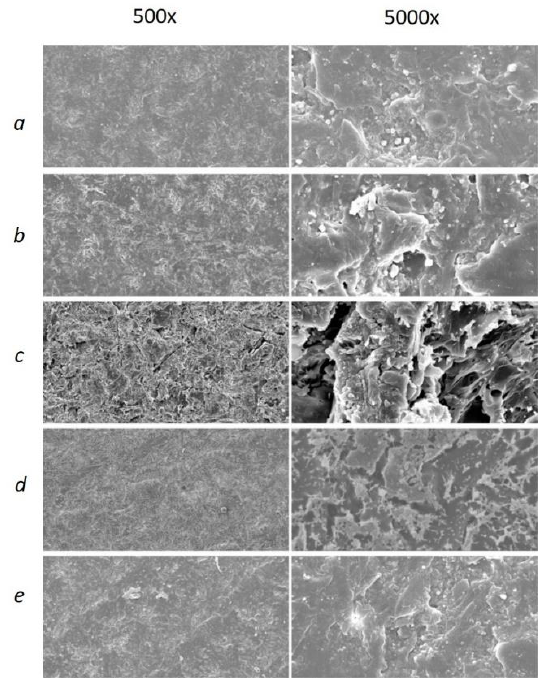
Figure 7. SEM images of Group B with 500× and 5000× magnification of reference ( a ), MMA ( b ), sandblasted ( c ), oxygen plasma ( d ), and nitrogen plasma ( e ) groups.